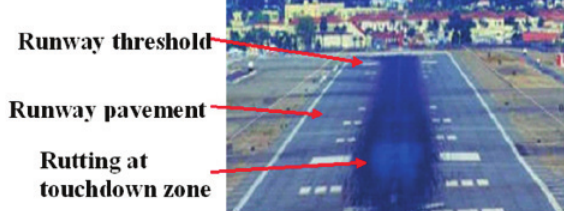
Fig. 1. Rutting at a runway touchdown zone (adapted from Fotosearch